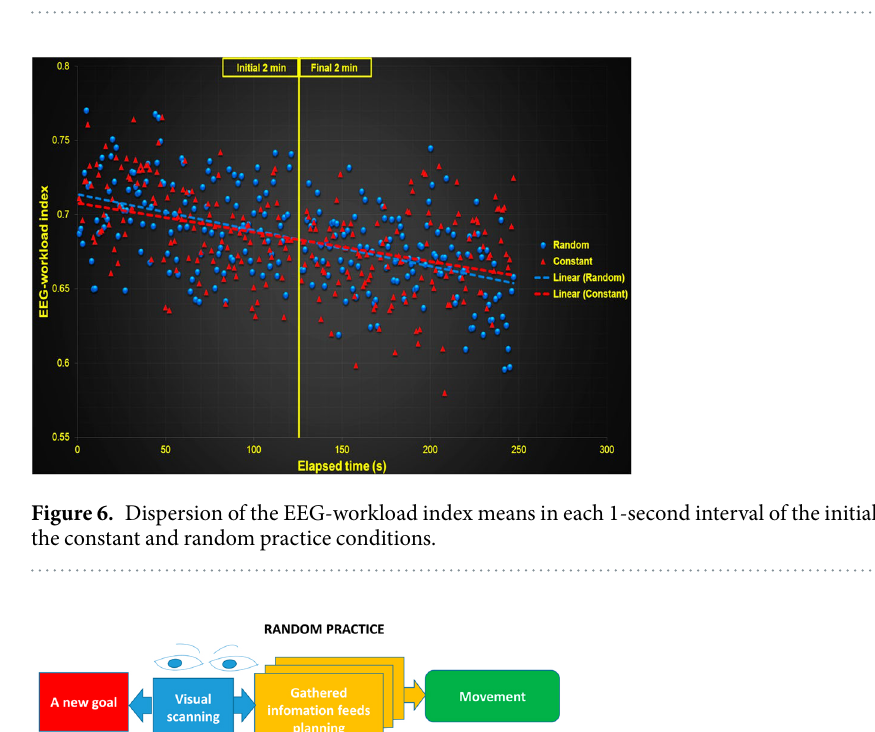
Figure 5. Dispersion of the EEG-engagement index means in each 1 second interval of the initial and final part of the constant and random practice conditions.